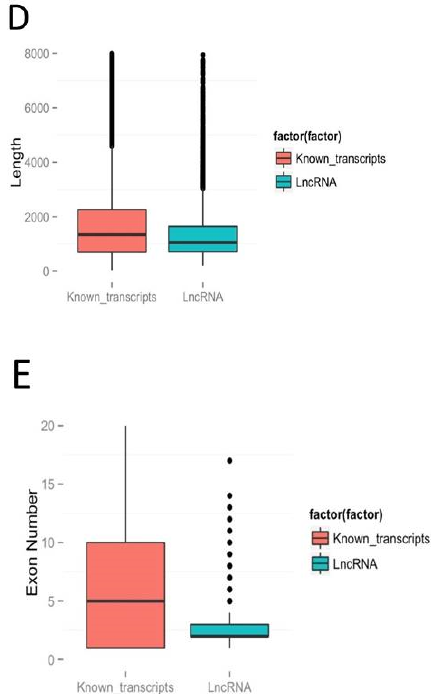
Figure 3. Location, chromosomal distribution and characterization of lncRNAs in bovine embryos at the 8-16-cell and morula stages with or without glutathione treatment. ( A ) Location of lncRNAs within genetic sequences. ( B ) Distribution of lncRNAs in bovine chromosomes. ( C ) Comparison of expression levels of lncRNAs with known transcripts. The mean transcript expression level (FPKM) of lncRNAs. ( D ) Length comparison between lncRNAs and known transcripts. ( E ) Comparison of the number of exons between lncRNAs and known transcripts. Abbreviations: GSH, glutathione; CDS, coding sequence; FPKM, per million fragments mapped; lncRNA, long non-coding RNA.